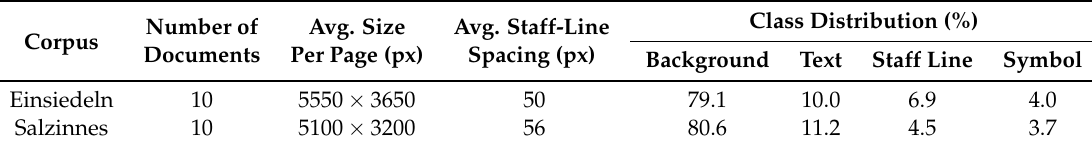
Table 1. Overview of the corpora used in our